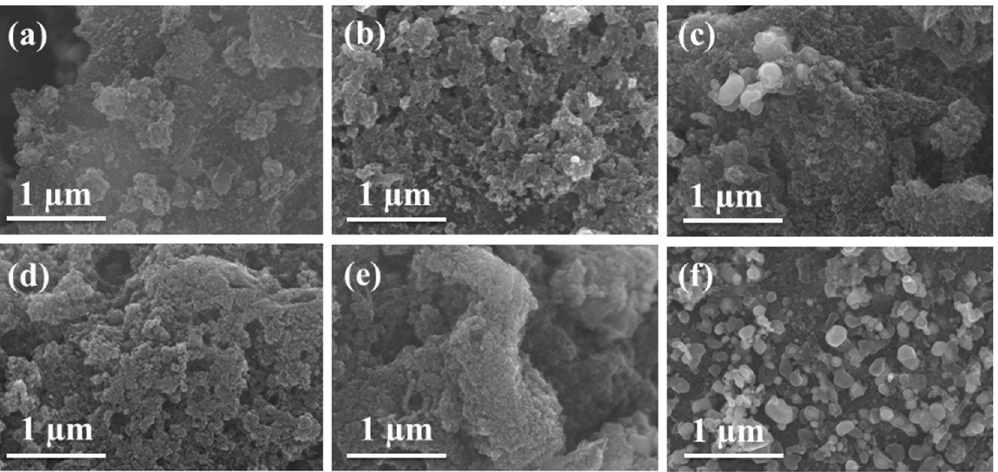
pyrolysis of iron oleate precursors, which were converted to Fe 3 C by sintering at high temperature after nitrogen doping. The XRD of the comparison samples N-Fe 3 C/rGO-H- 700 and N-Fe 3 C/rGO-H-900 are shown in Figure S3, and the calcination temperature has no effect on the formation of the crystalline phase of Fe 3 C.